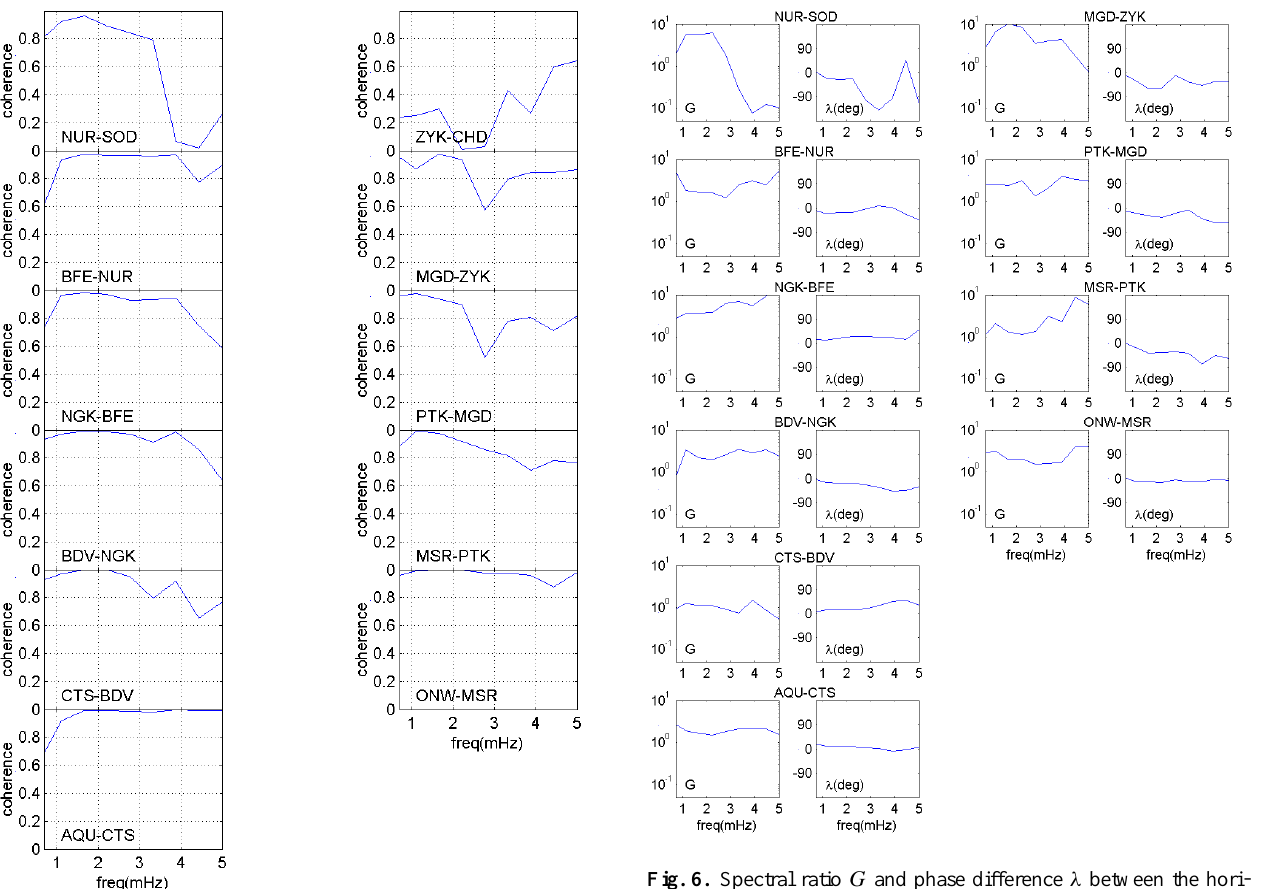
Fig. 6. Spectral ratio G and phase difference λ between the hori- zontal geomagnetic field H component in the time interval 07:00– 09:00UT at pairs of adjacent stations (assuming the lower latitude station as the